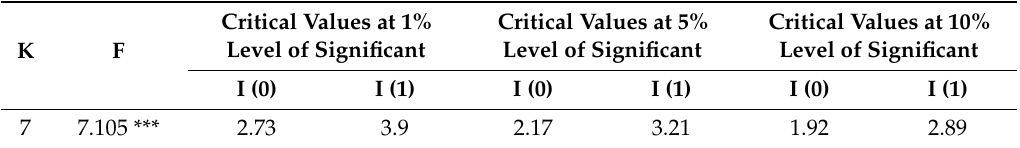
Table 5. ARDL bounds test results for Cointegration.